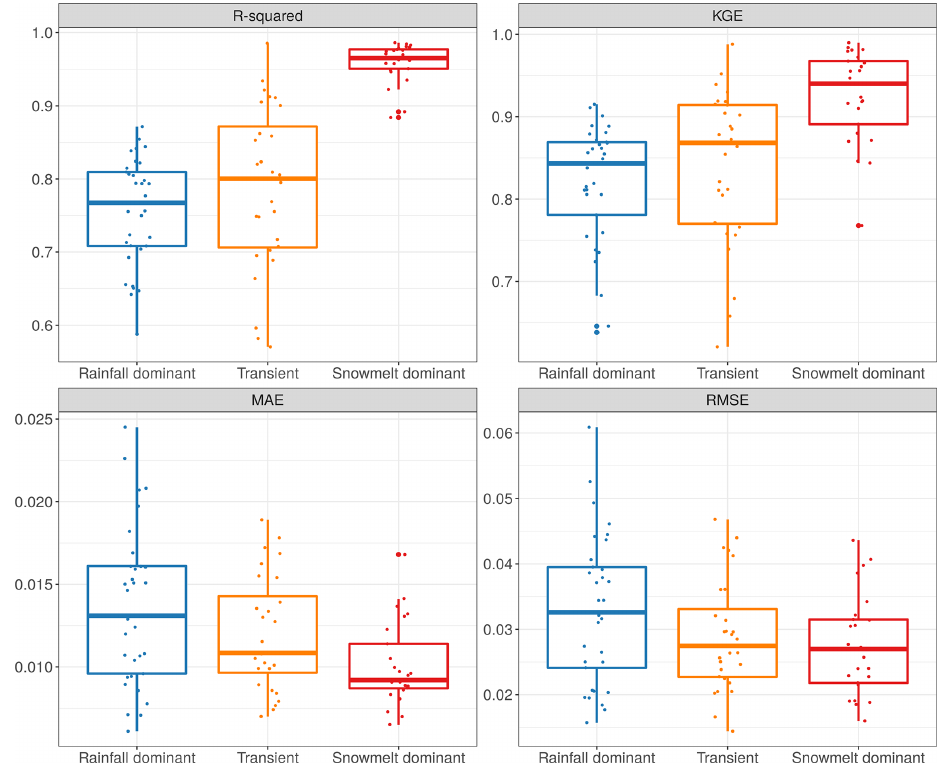
Figure 8. Streamflow daily forecast scores computed over the validation period for the RF model in four metrics: R 2 , KGE, MAE, and RMSE. Table 4. Descriptive statistics of the four criteria used to evaluate the overall performance of RF: R 2 , KGE, MAE, and